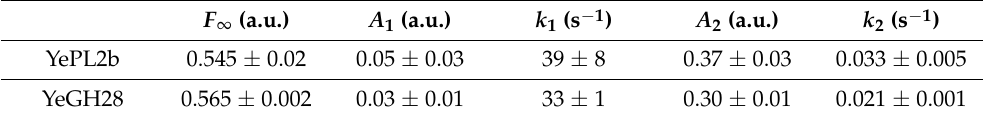
Figure 4. Oligogalacturonide release from CAZyme-catalyzed degradation of polygalacturonic acid detected by TogB D363C-MDCC. Representative fluorescence time courses for product released by 250 nM YePL2b (( A ), black fluorescence time course) or 250 nM YeGH28 (( B ), black fluorescence time course) in the presence of 0.5 mg/L PGA and detected by 250 nM TogB D363C-MDCC. Negative controls in the absence of CAZyme (red fluorescence time courses) and in the absence of PGA (blue fluorescence time courses) are shown. Table 2. Oligogalacturonide release fit parameters obtained via CAZyme-catalyzed PGA degradation. The fitting of the two-exponential function (Equation (6)) to biphasic fluorescence time courses of oligogalacturonide release shown in Figure 4 details underlying enzyme kinetic parameters. Fit parameters for a polysaccharide lyase (YePL2b) and a glycoside hydrolase (YeGH28) are reported (mean ± s.d., n = 6 replicates for each enzyme).